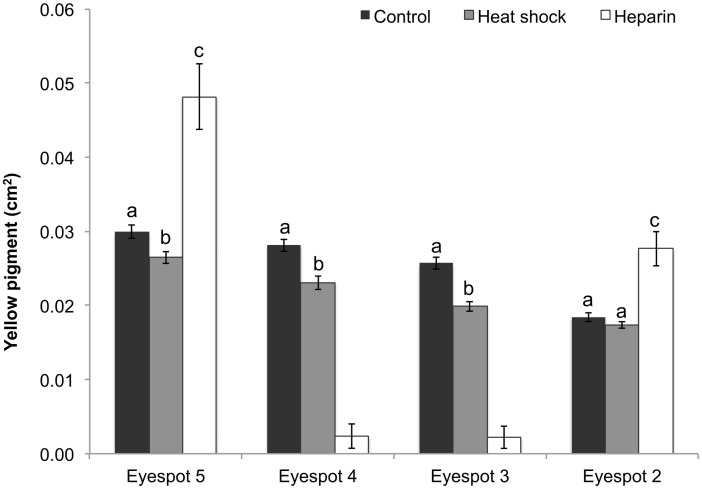
Area of yellow pigment across all four eyespots in the different treatments.Data represent the area in cm2 with error bars representing 1 SE from the mean. The 2-way ANCOVA was performed on log10-transformed data. Eyespots 3 and 4 in the heparin treatment were excluded from the statistical analysis, as eyespots were mostly abolished by the treatment. Results shown in Table 1. Different letters above the bars indicate significant differences within each individual eyespot.